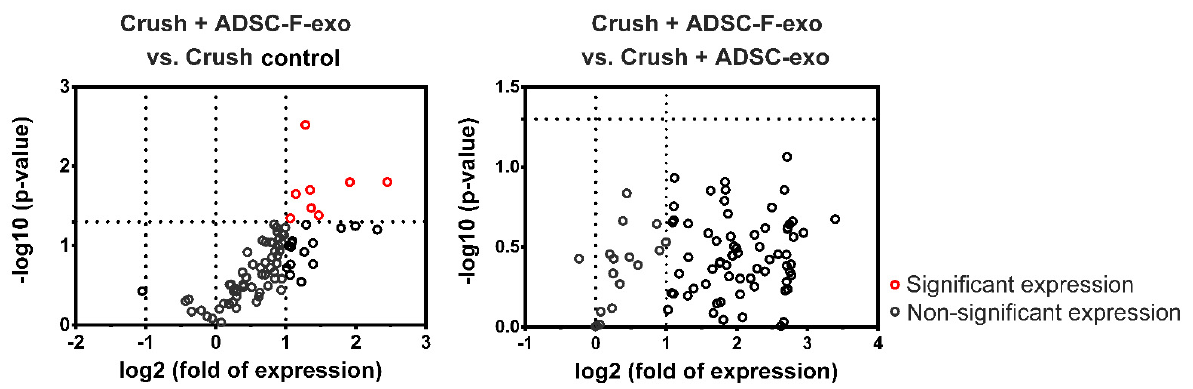
Figure 3. Representative plot of differentially expressed genes in the distal nerve segment of C57BL/6 mice treated with ADSC-F-exo vs. PBS ( left graph ) or ADSC-exo ( right graph ) determined by PCR array on post-crush day 2. Genes showing at least 2-fold differential expression and p < 0.05 between experimental and nerve crush control groups are considered significantly upregulated (indicated in red). Statistical analysis was performed by one-way analysis of variance with a post-hoc Fisher’s least significant difference test.